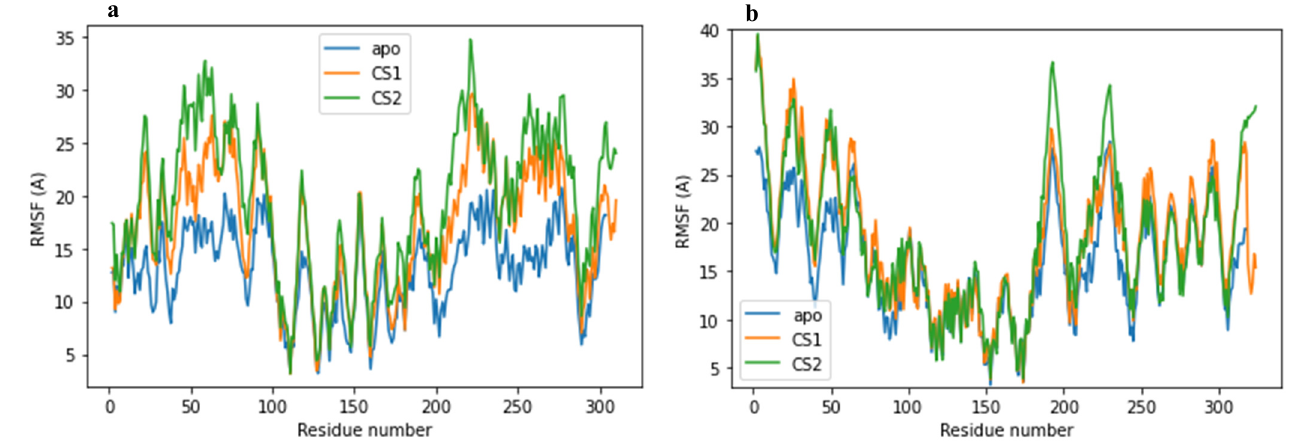
Figure 4. Root-mean-square fluctuation plot for ( a ) apo-3CLpro protease (blue) and complexes of 3CLpro with CS1 (orange) and CS2 (green) during the 600 ns MD simulation time. ( b ) apo-PLpro protease (blue) and complexes of PLpro with CS1 (orange) and CS2 (green) during the 600 ns MD simulation time.